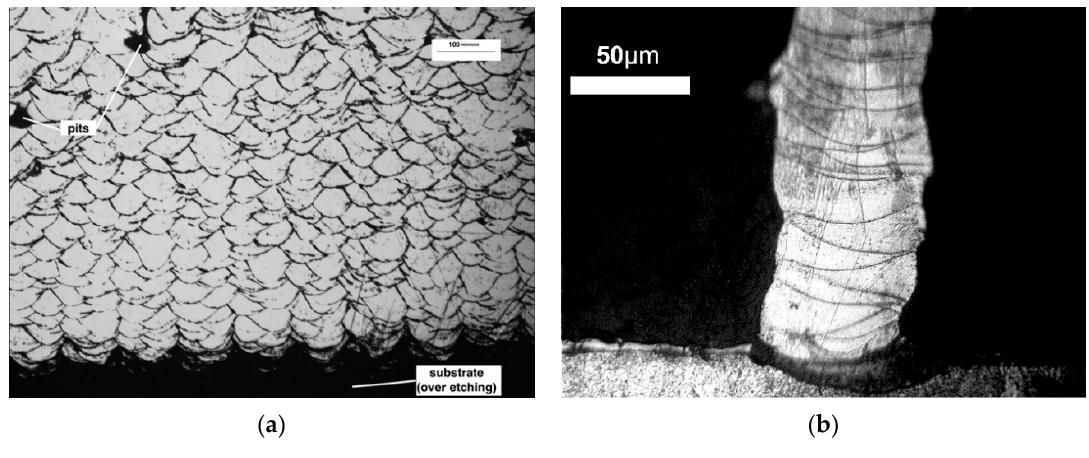
Figure 13. Microstructure of large ridge ( a ) for shear strength test and ( b ) a designed 100 mm feature. Figure 12. Cross-section of micro features printed by